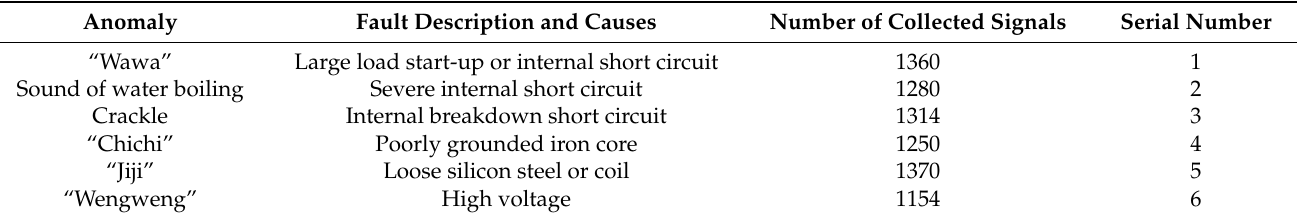
Table 1. Common transformer body sound anomaly analysis.